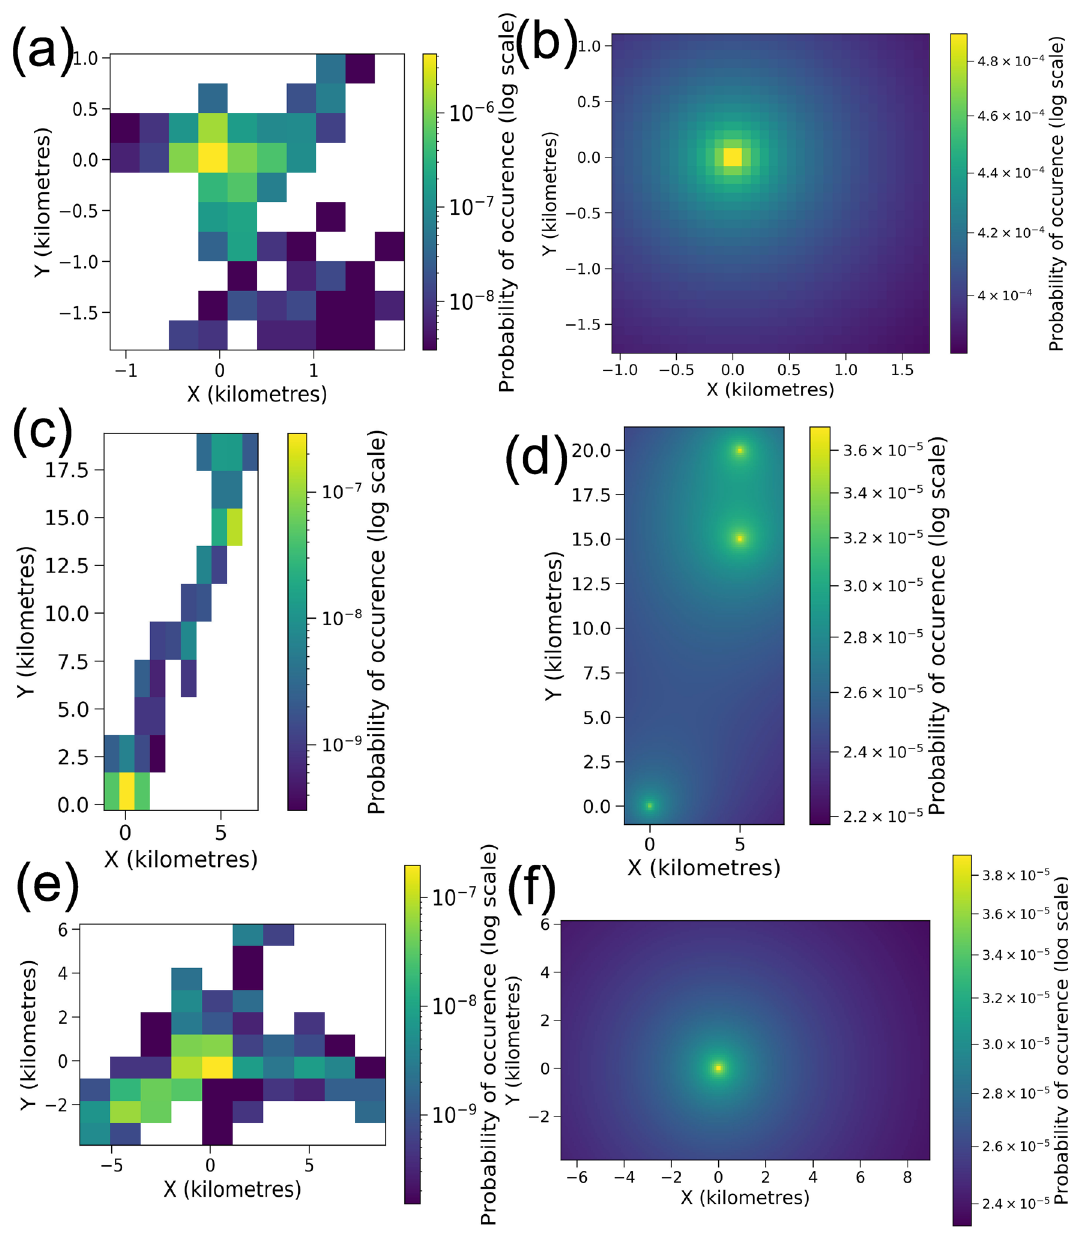
Figure 11. Visualization of the probability of space use over the territories from empirical data (plots on the left) against the steady-state probability distributions from Fokker–Planck equation (plots on the right). X and Y distances along the respective axes are in kilometres. The empirical plots were generated from 2-d histograms of location data. The location data was first projected to UTM coordinates. The origin was fixed at the nest for breeding birds and at one of the roosting sites for non-breeding hornbills. The smaller grid size is necessary to get greater accuracy in the numerically generated solutions. The numerical solutions also demand axes that are symmetric around the origin. Therefore, the histogram based probability distributions from data have very different grid sizes for their visualizations. The plots based on numerical solutions have been cropped to match the extent of axes of those from empirical data. ( a , b ) GH1Br, ( c , d ) GH2NBr, ( e , f )